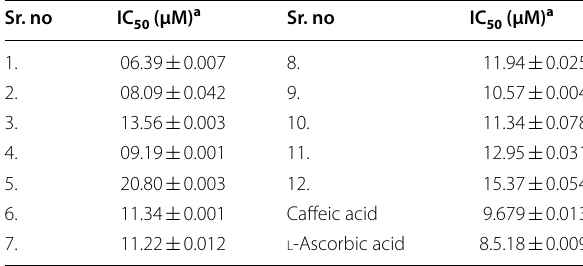
Table 4 DPPH radical scavenging of caffeic acid derivatives